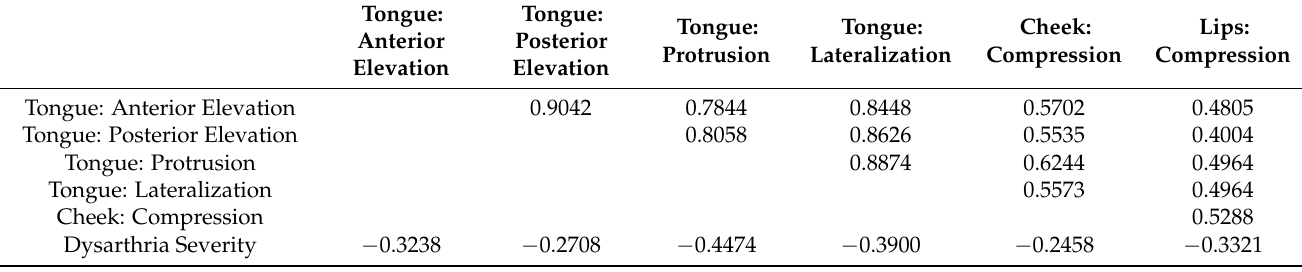
Table 4. Pearson Correlations Among Orofacial Strength Measures for All Participants ( N = 112), and Spearman Correlations Between Orofacial Strength Measures and Dysarthria Severity for Participants in the Experimental Groups ( N = 79).